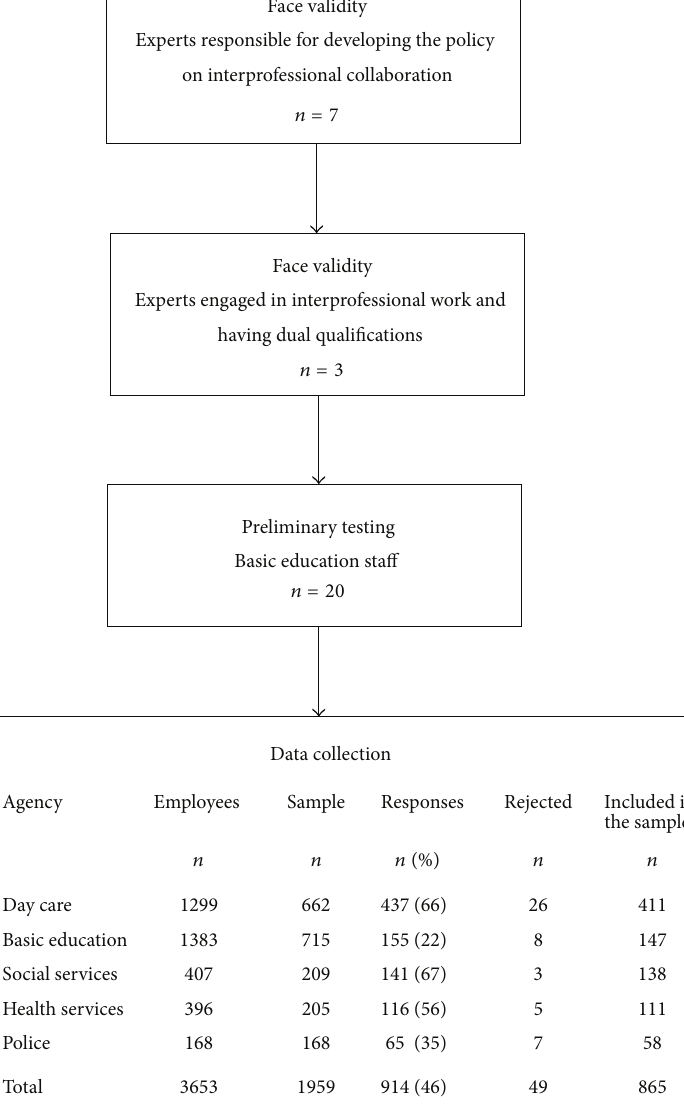
Figure 1: Scale development and data collection by fields (𝑛 = 865)